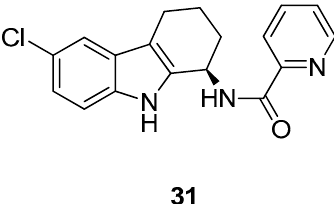
Figure 13. Structure of N -[(1 R )-6-Chloro-2,3,4,9-tetrahydro-1 H -carbazol-1-yl]-2-pyridinecarboxamide (GSK983, 31 ).